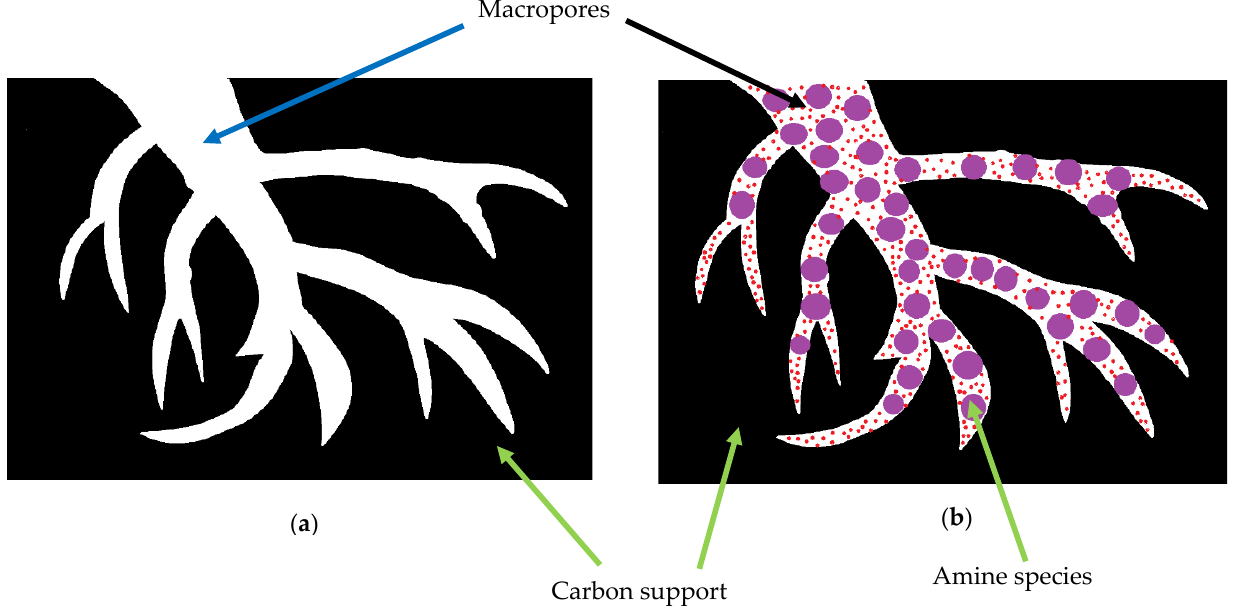
Figure 6. Pore structure of ( a ) non-impregnated porous carbon support and ( b ) amine-functionalized carbon with blocked pores (Reprinted with permission from ref. [226]).